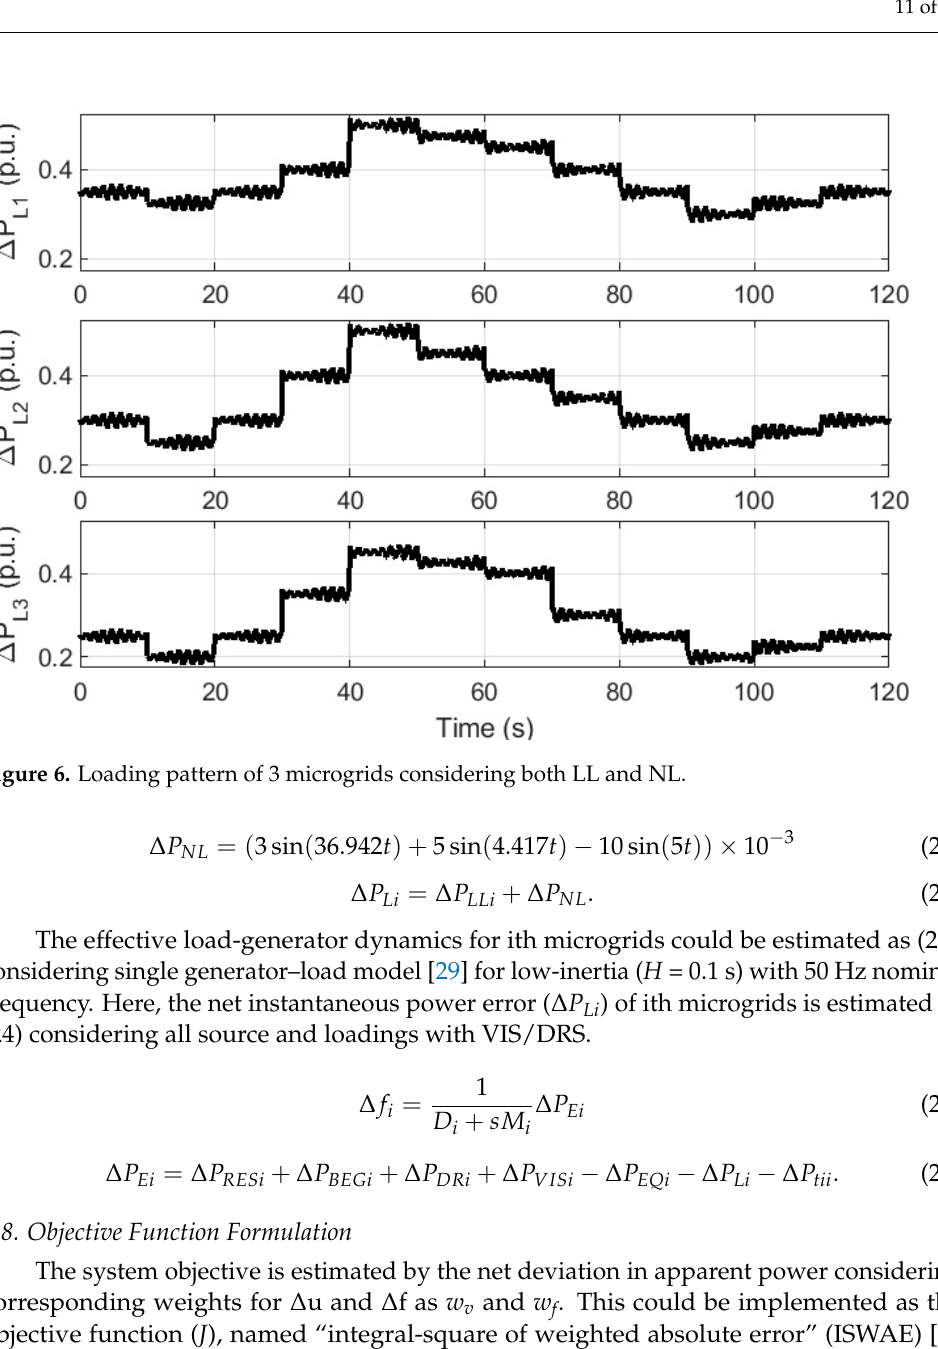
Figure 5. Loading pattern of 3 microgrids considering LL.